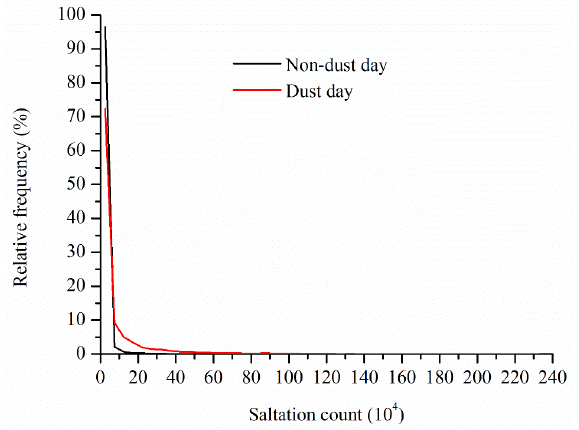
Figure 9. Relative distributions of hourly saltation count on both dust and non-dust days.